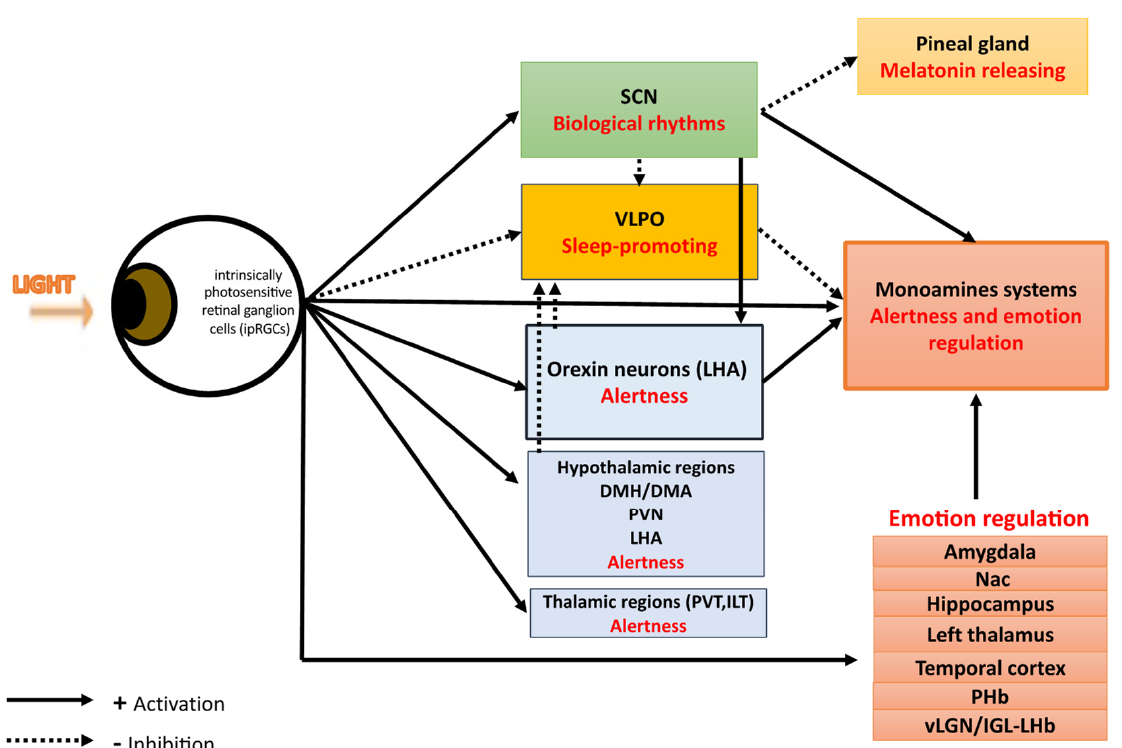
Figure 2. Photic regulation of mood and associated retina–brain pathways. Table 1. What is known and what is still unknown.